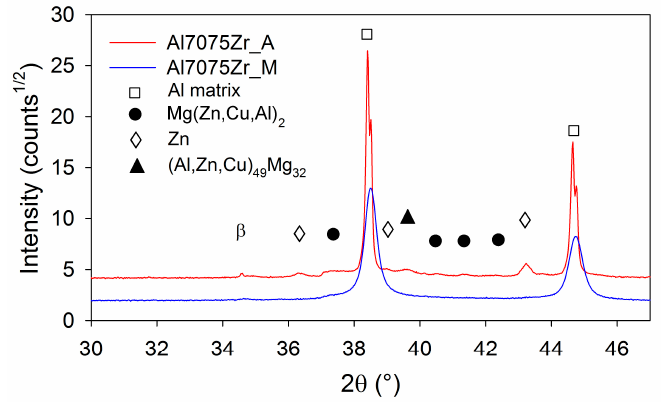
Figure 6. The comparison of XRD patterns for atomized and milled Al7075Zr powders.